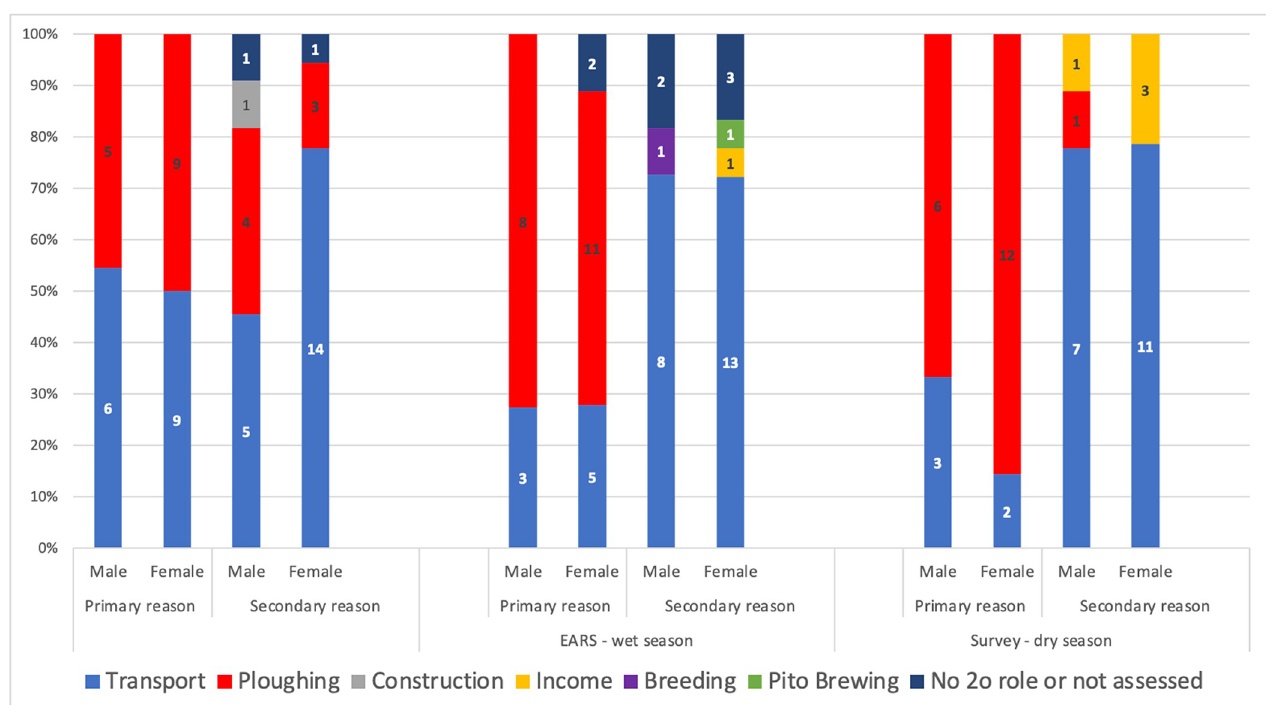
Fig 5. All-source reasons why people keep donkeys in northern Ghana, split by gender (n = 29). Source: Maggs, 2022 [1].